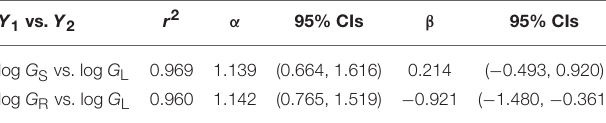
TABLE 1 | Reduced major axis regression parameters for the scaling of annual growth in stem, leaf, and root dry mass ( G S , G L , and G R , respectively) per plant per year (log 10 -transformed data plotted in Figure 5 ). Original units